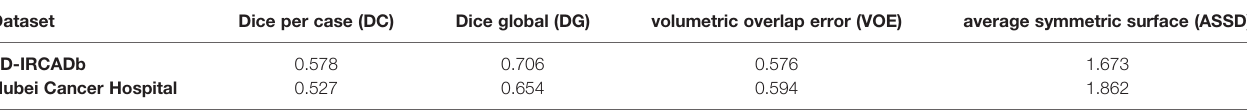
TABLE 3 | Tested our trained model from the LITS dataset on 3D-IRCADb dataset and Hubei Cancer Hospital dataset. Dataset